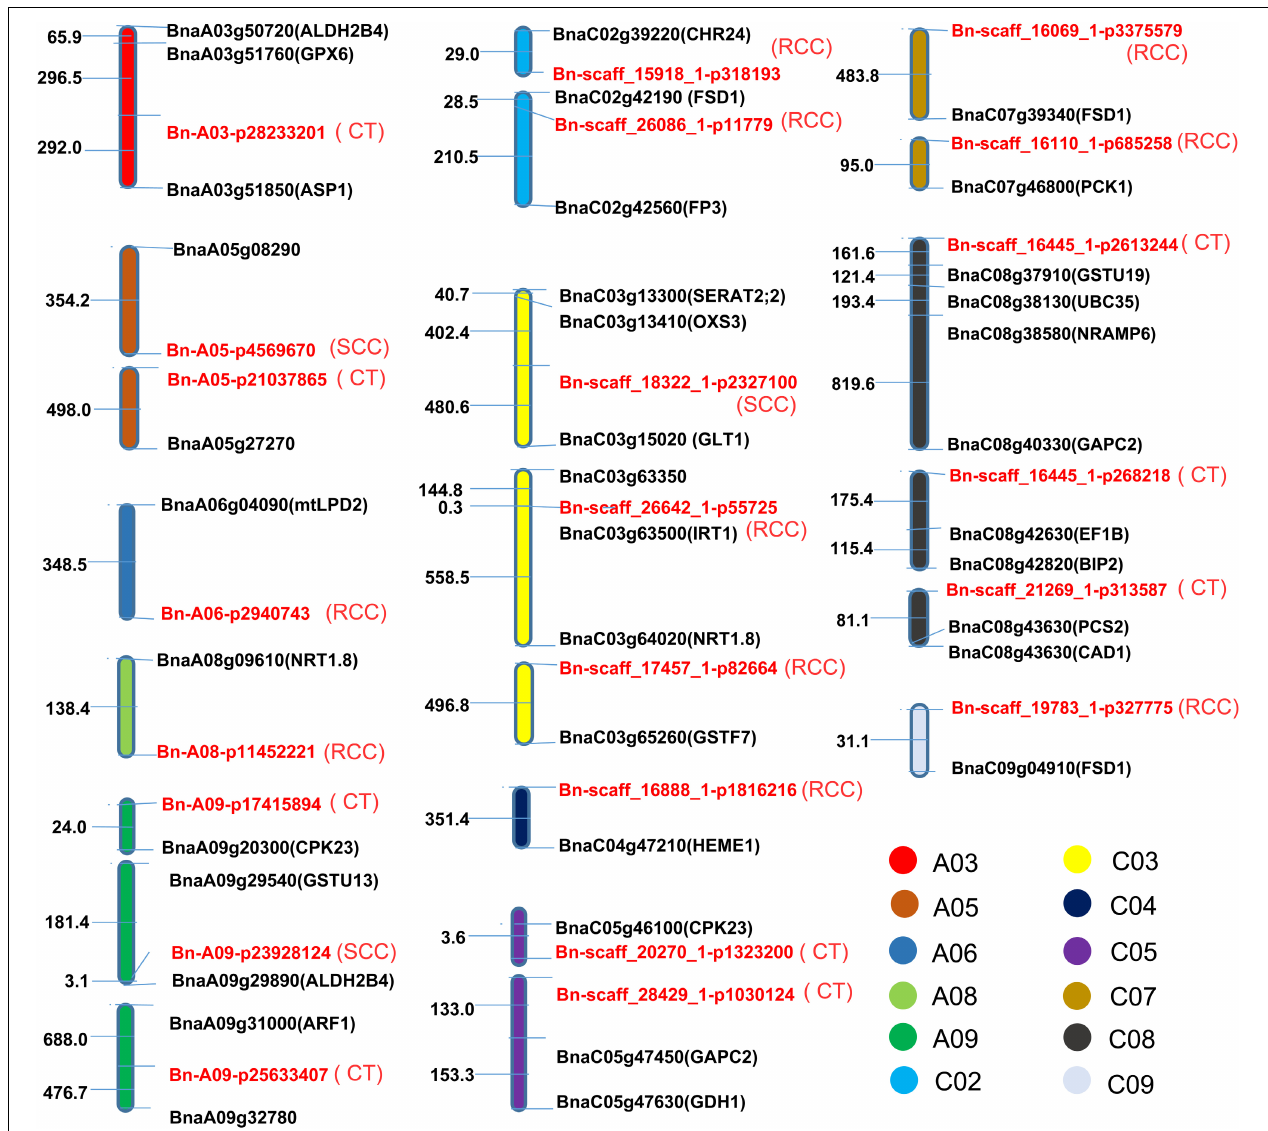
FIGURE 5 | The distribution pattern of candidate genes and the corresponding SNPs associated with Cd accumulation. The abbreviations of orthologous genes in Arabidopsis thaliana are shown in brackets after the candidate genes. SNPs are marked in red. Numbers represent the relative distances in the genome, 1 = 1